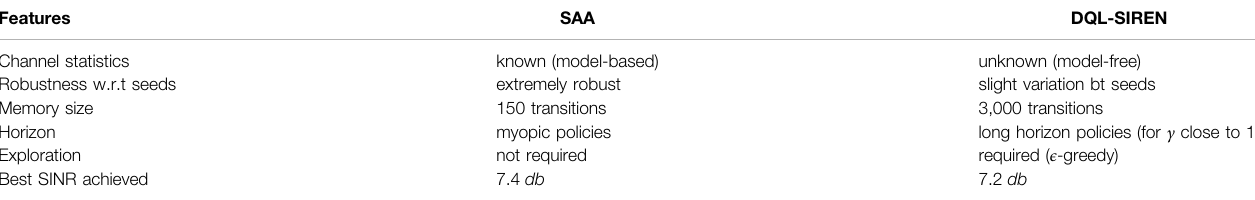
TABLE 1 | Table of comparison between the two methods regarding key features.